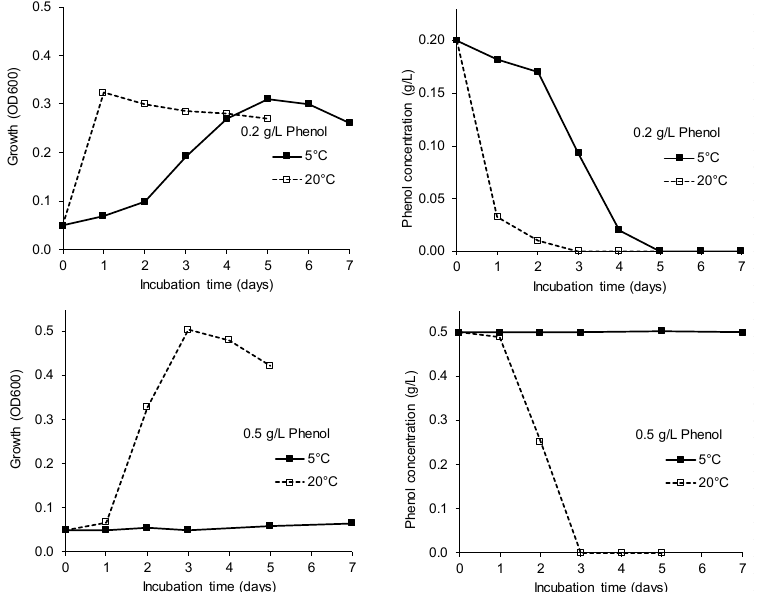
Figure 4. Effect of temperature and phenol concentration (top panel: 0.2 g/L; bottom panel: 0.5 g/L) on growth (left panels) and phenol degradation (right panels) by strain Pseudomonas sp. AM0-06 (mean values of three replicates, SDs were ≤ 10%).